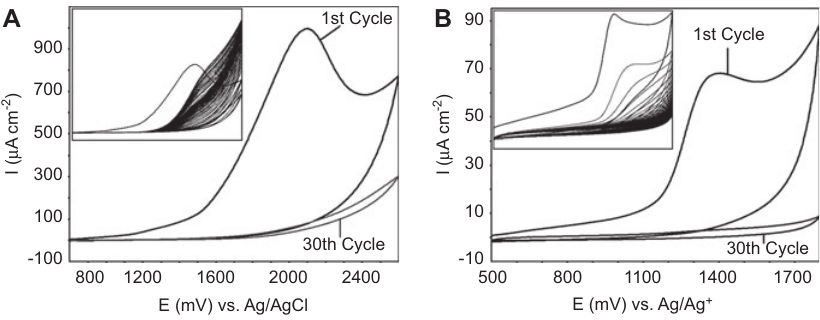
Figure 2 Cyclic voltammogram of 1 m m PolyChr/GC (A) in PBS, pH 7, vs. Ag/AgCl/(3 m KCl), (B) in MeCN containing 100 m m TBATFB vs. Ag/Ag + (10 m m ). Sweep rate is 100 mV s -1 .